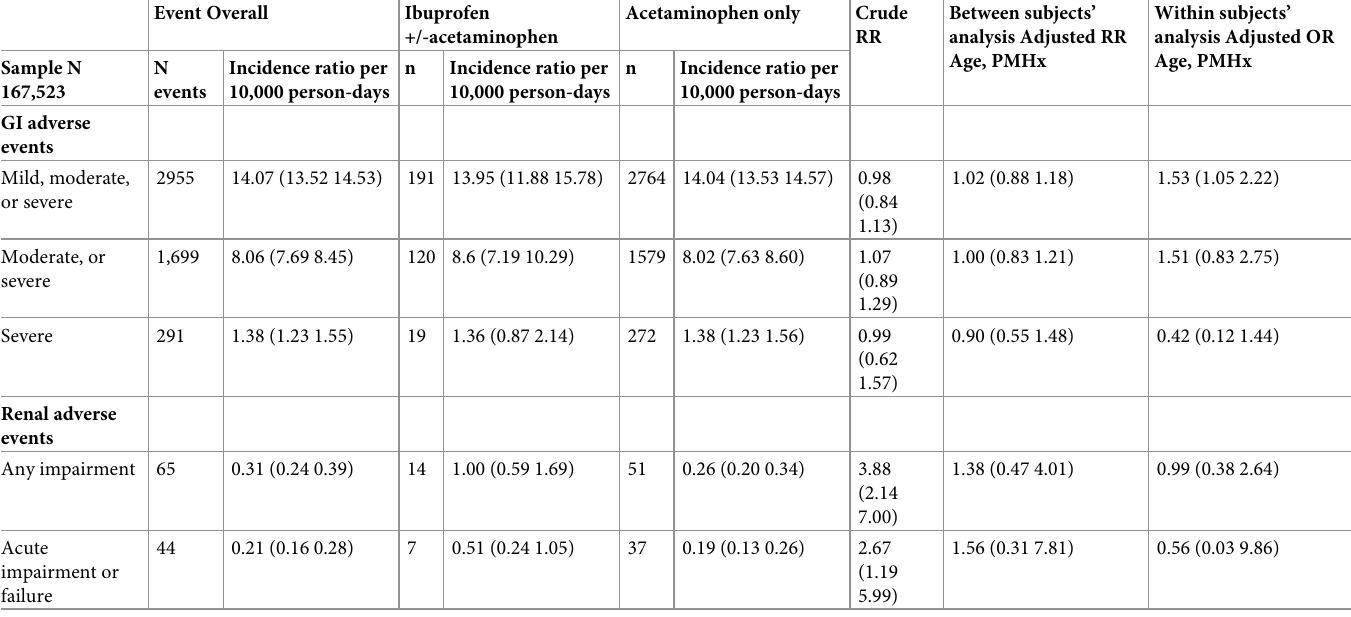
Table 6. Hypothesis 2 at 14-day follow